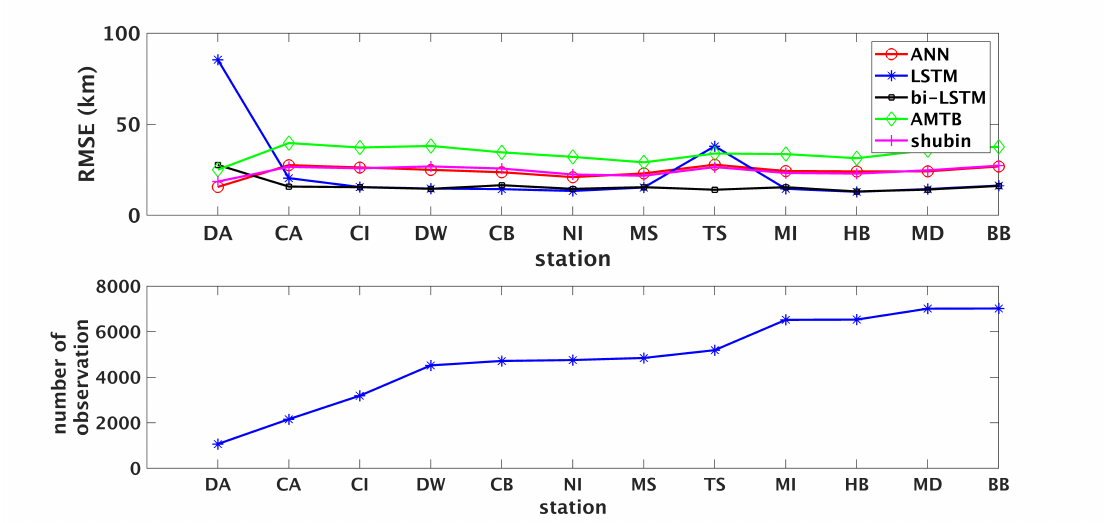
Figure 6. ( a ) RMS for each of the five models in each ionosonde station; and ( b ) number of sample sets in each